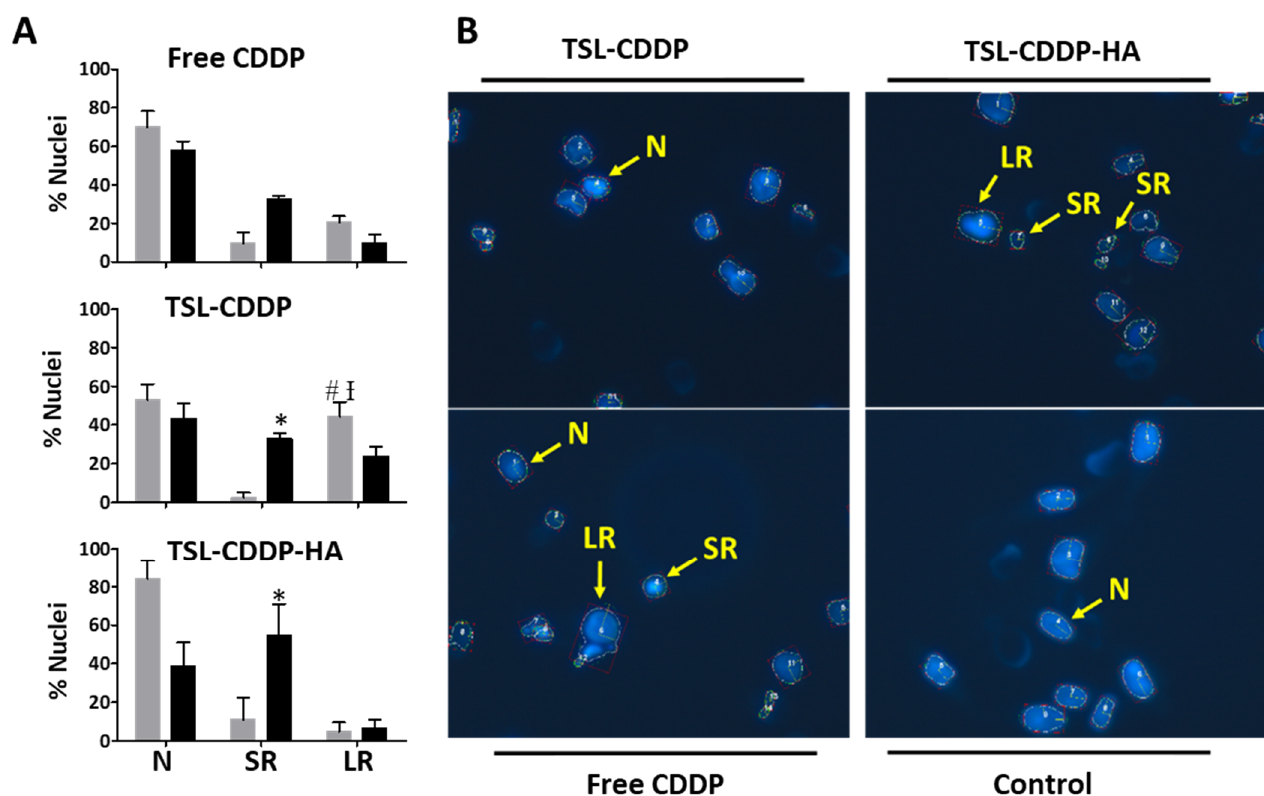
Figure 2. ( A ) Nuclear morphometric distribution of MDA-MB-231 cell line exposed to IC50 of different treatments for 48 h, without (gray bars) or with hyperthermia (black bars). ( B ) Fluorescence images of nuclei from the cell line MDA-MB-231, stained with Hoescht, obtained after 48 h of the different treatments at the IC50 of each formulation. Enhancement, 40×. Data are expressed as mean ± error standard of three independent experiments * Significant difference between heating and no heating for the same group of treatment. # Significant difference from free CDDP. Ɨ Difference from TSL-CDDP-HA. p < 0.05 (Tukey’s test). Abbreviations: N: normal; SR: small and regular; LR: large and regular.